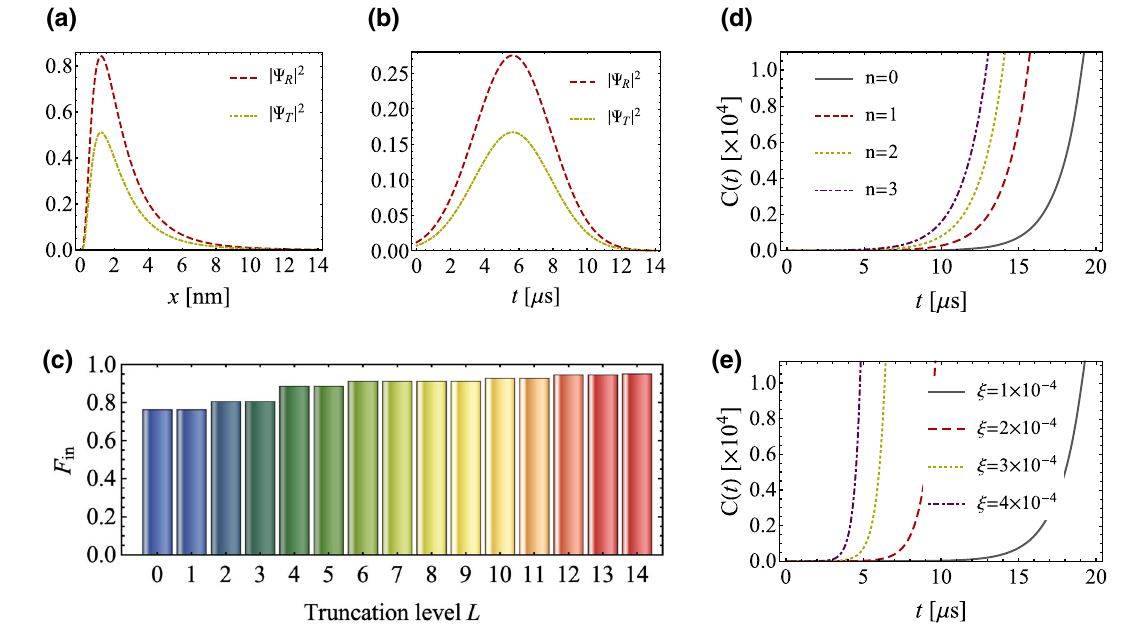
Fig. 2 Transmission/reflectionprobabilityandOTOC. a Thetransmis- sion and reflection probability in Eq. (7) as function of ion displacement x , with fixed width (cid:16) = ¯ h ω , ξ = 0 . 01, initial energy ε 0 = − 0 . 5 ¯ h ω , and at time t = 2 . 86 µ s; b the transmission and reflection probabil- ity as a function of time t , with ion displacement x = 1 . 35nm; c the fidelity of the prepared initial state (6) for various truncation levels L